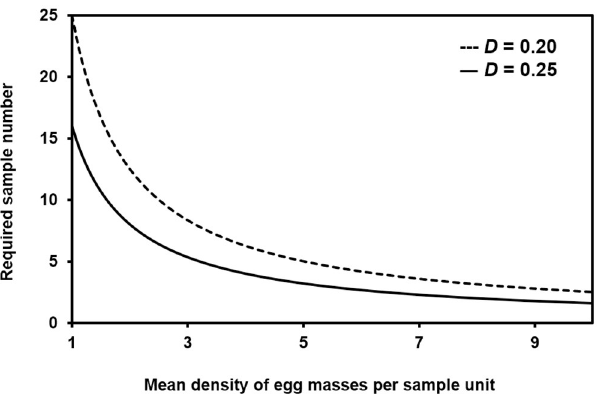
Fig 1. Required sample numbers according to mean densities of R . shantungensis egg masses in fixed precision level ( D ) of 0.20 and 0.25.